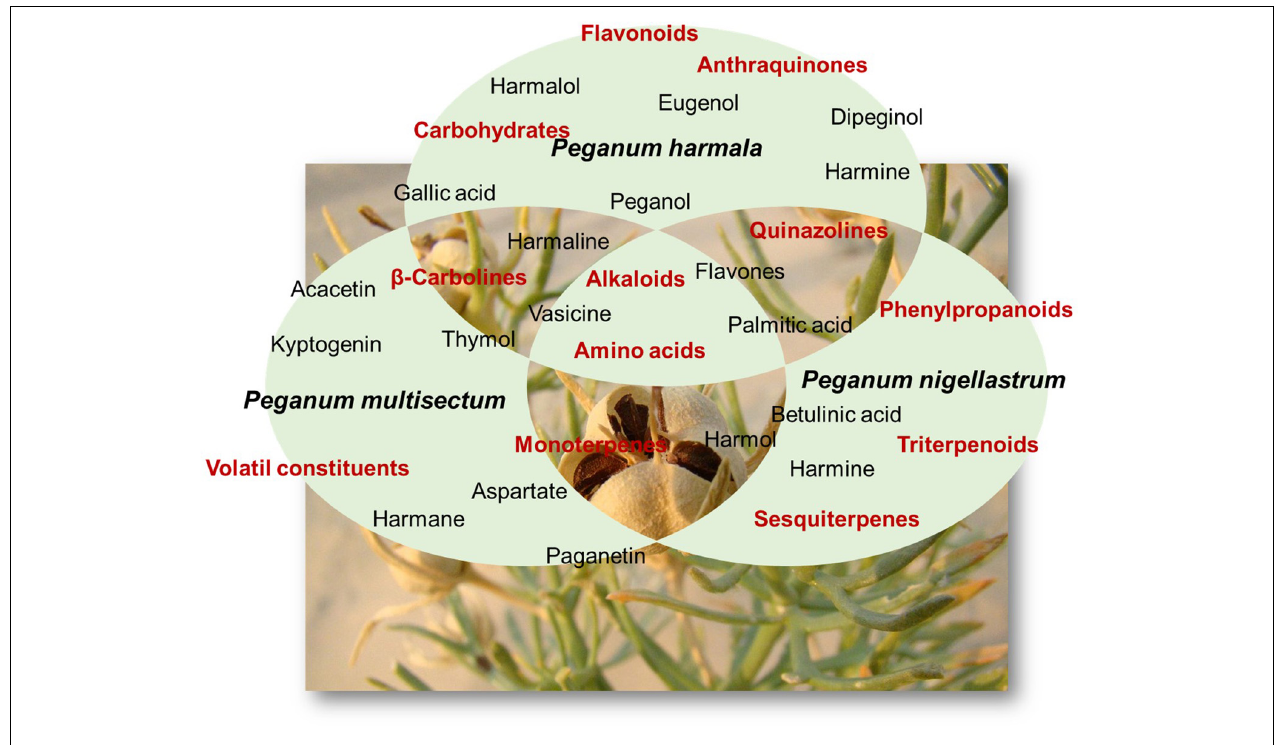
FIGURE 1 | Main chemicals and families of compounds found in Peganum